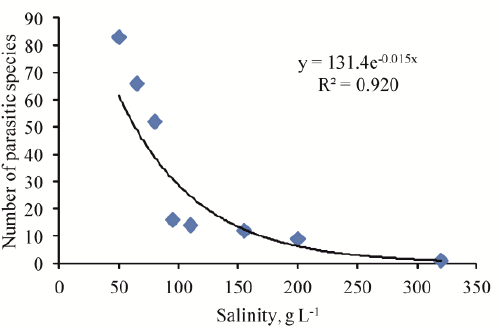
Figure 1. The number of parasites species depending on the upper limit of the habitat’s salinity . Between the number of free-living animal species and their upper salinity limit, the same relationship was also found before [3,69], which can be described as (R = 0.992, p = 0.0001):